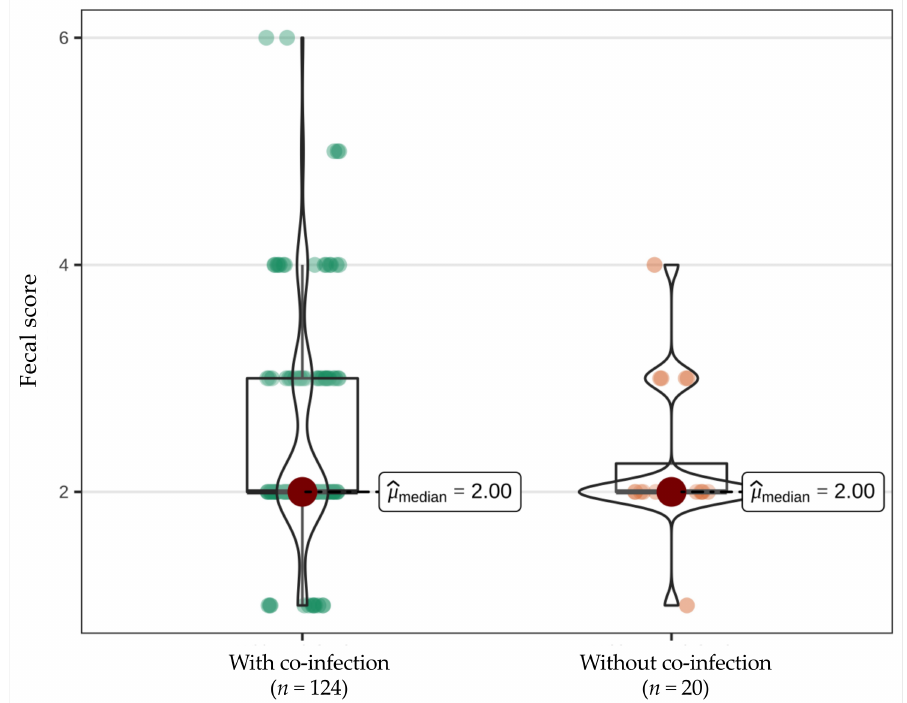
Figure 4. Box-Violin plots with medians (red points) display the non-normally distributed nature of the fecal score and demonstrate that there is no difference in fecal score between cats with feline coronavirus (FCoV) infection with or without co-infection with other potential enteropathogens ( p = 0.455) according to the nonparametric Mann–Whitney U